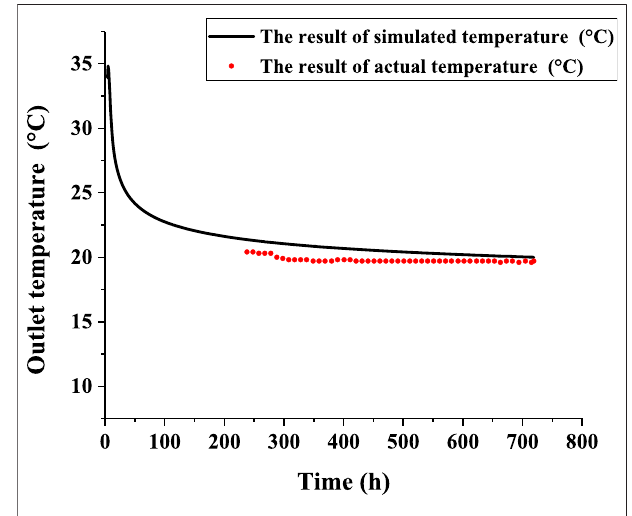
FIGURE 3 | The comparison of simulation and actual